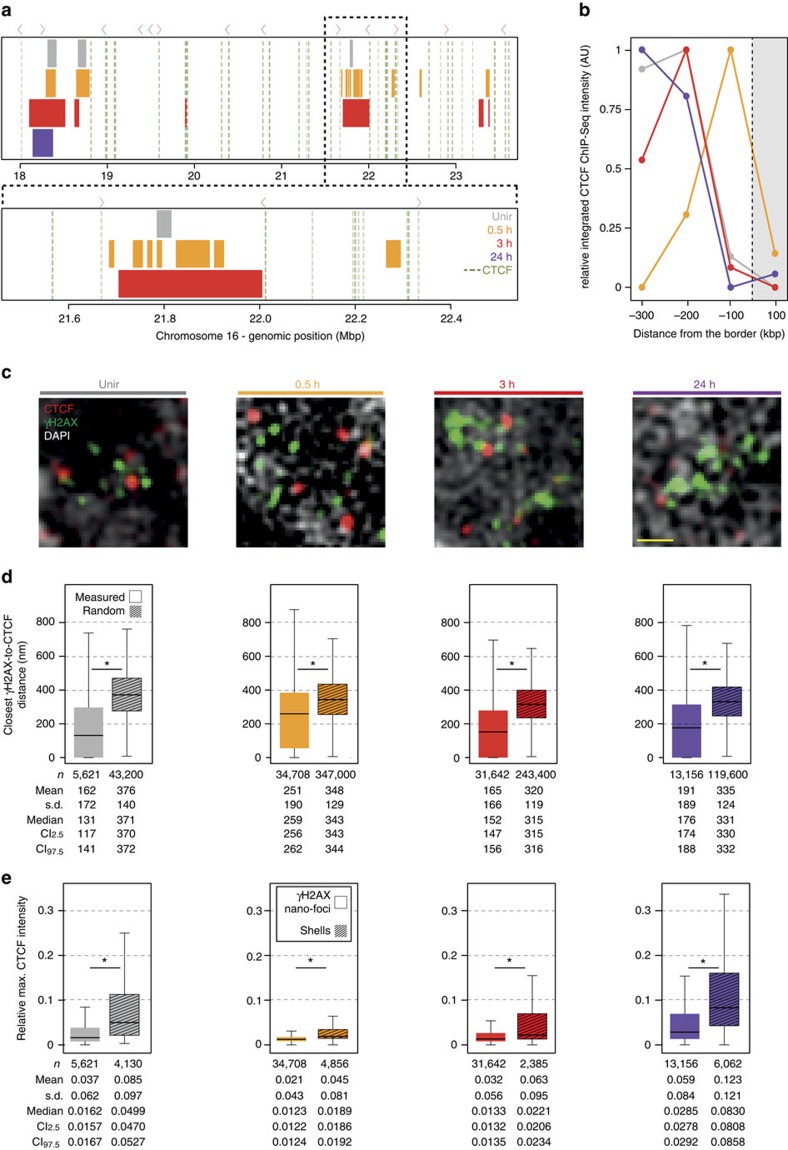
Genomic and microscopic analysis of CTCF spatial distribution in γH2AX-decorated chromatin.(a) Genomic localization of γH2AX ChIP-Seq domains (coloured bars) and CTCF genomic footprint (dashed green lines) in a representative region of chromosome 16. Dashed black line: magnification. Coloured arrowheads: orientation of CTCF-binding sites (red: forward; green: reverse). Details about γH2AX ChIP-Seq domains are in Supplementary Methods and Supplementary Fig. 4. ChIP-Seq CTCF profiles were retrieved from publicly available databases (UCSC Accession: Encode wgEH000080, wgEH000543, wgEH000401 and wgEH000470). (b) CTCF occupancy outside or inside γH2AX ChIP-Seq domains. The intensity of each CTCF peak in 100 kb bins upstream and downstream of the border of γH2AX ChIP-Seq domains (grey box) is summed and then presented as one-sided distribution. The bins range from ±300 to ±200, ±200 to ±100, ±100 to 0 and 0 to ±100 kb (inside the domain), with 0 being the border of each domain. AU: arbitrary unit. Genome-wide CTCF footprint localization relative to γH2AX ChIP-Seq domains' borders. For each domain, the distance in kb between its boundaries and the closest CTCF peak is measured and plotted as a bar (dashed lines). (c) Representative 3D-SIM images of immuno-stained γH2AX and CTCF before and during DDR. Scale bar, 500 nm. (d) Quantification of the closest centroid-to-centroid distance between CTCF and γH2AX nano-foci from 3D-SIM images. Measured (filled boxes) and simulated (patterned boxes) distances are shown. The latter were obtained from simulated random distributions of CTCF and γH2AX nano-foci (100 iterations). (e) Quantification of maximum CTCF intensity in γH2AX nano-foci and in surrounding shells. Maximum CTCF fluorescence in the segmented space normalized over the maximum CTCF fluorescence of the entire nucleus is plotted. All boxes and whiskers are as in Fig. 1. n: measured distances (d) or analysed shells (e) from two independent experiments. d,e: Mann–Whitney test: P<10−3.